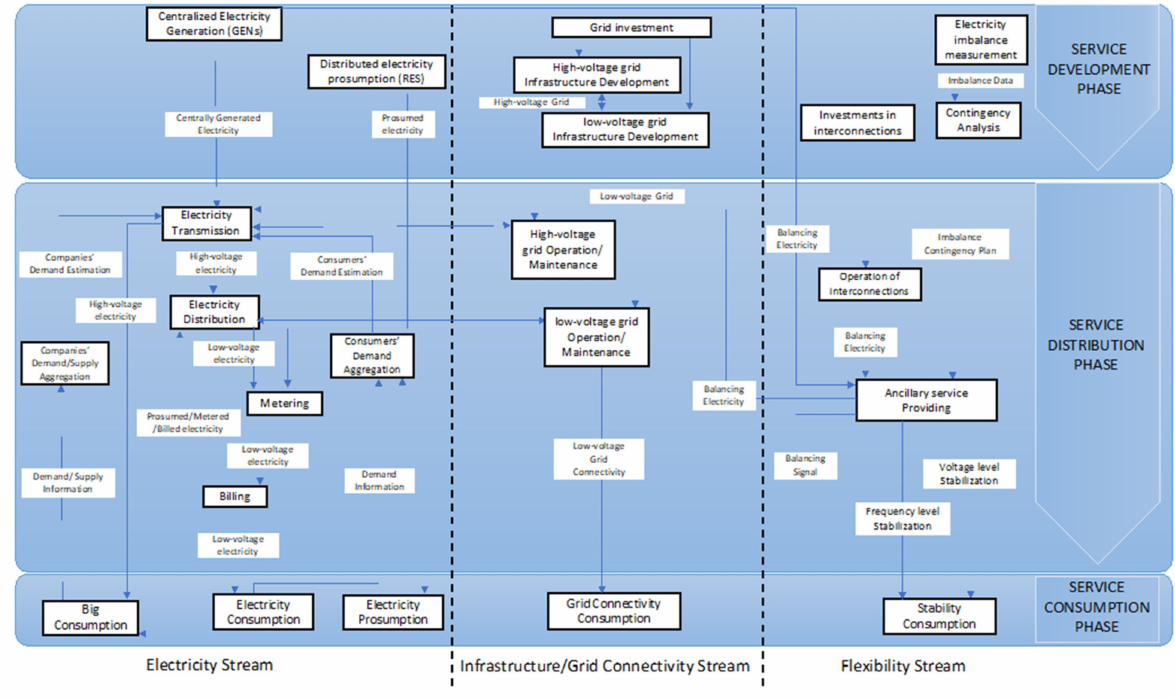
Figure 3. Service streams, critical activities, and deliverables in the current electricity market. Reproduced from [10], Institute of Electrical and Electronics Engineers (IEEE):